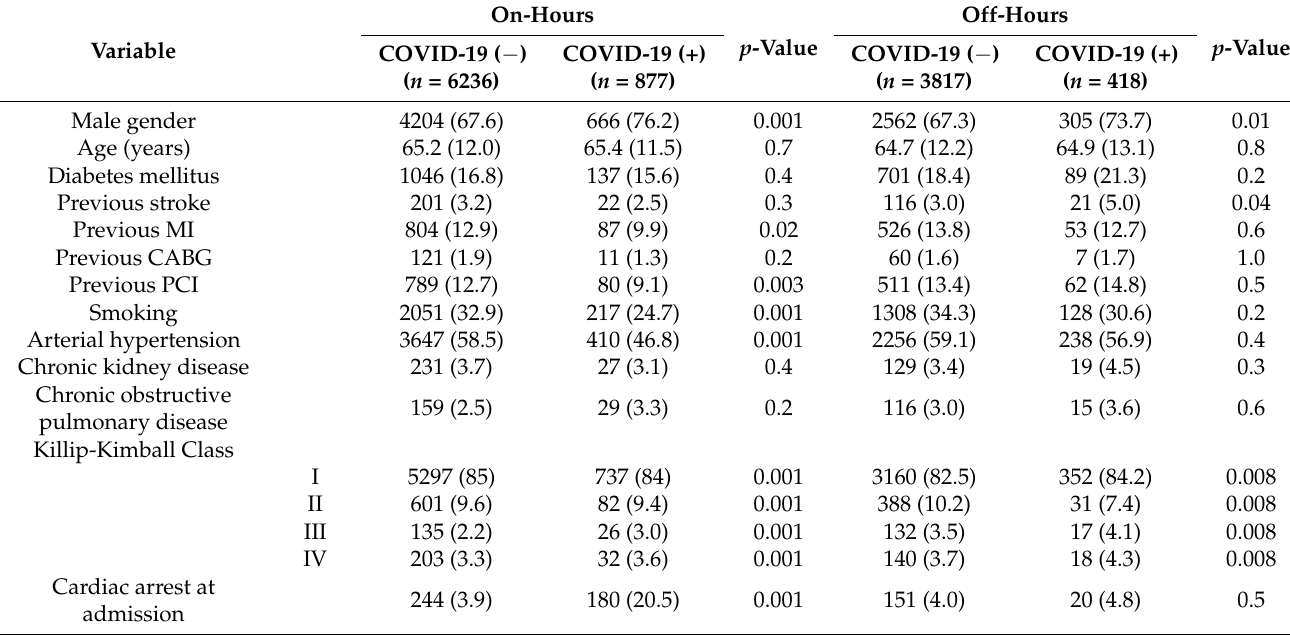
Table 1. Baseline characteristics before propensity score matching.